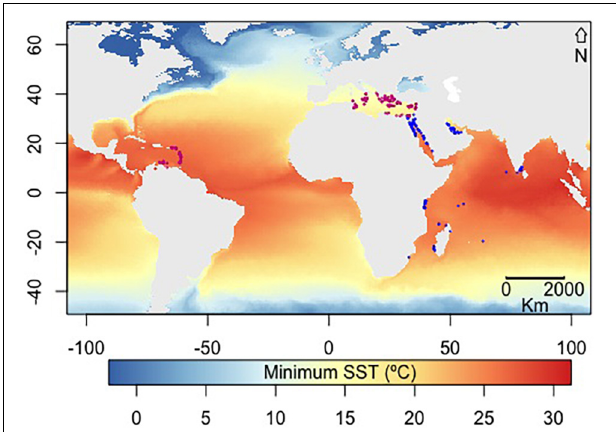
FIGURE 1 | Minimum SST and records of Halophila stipulacea included in the current analysis showing its distribution in its native range in the Indian Ocean and Red Sea (blue points) and exotic Mediterranean and Caribbean ranges (pink points). Minimum SST was extracted from bio-oracle.